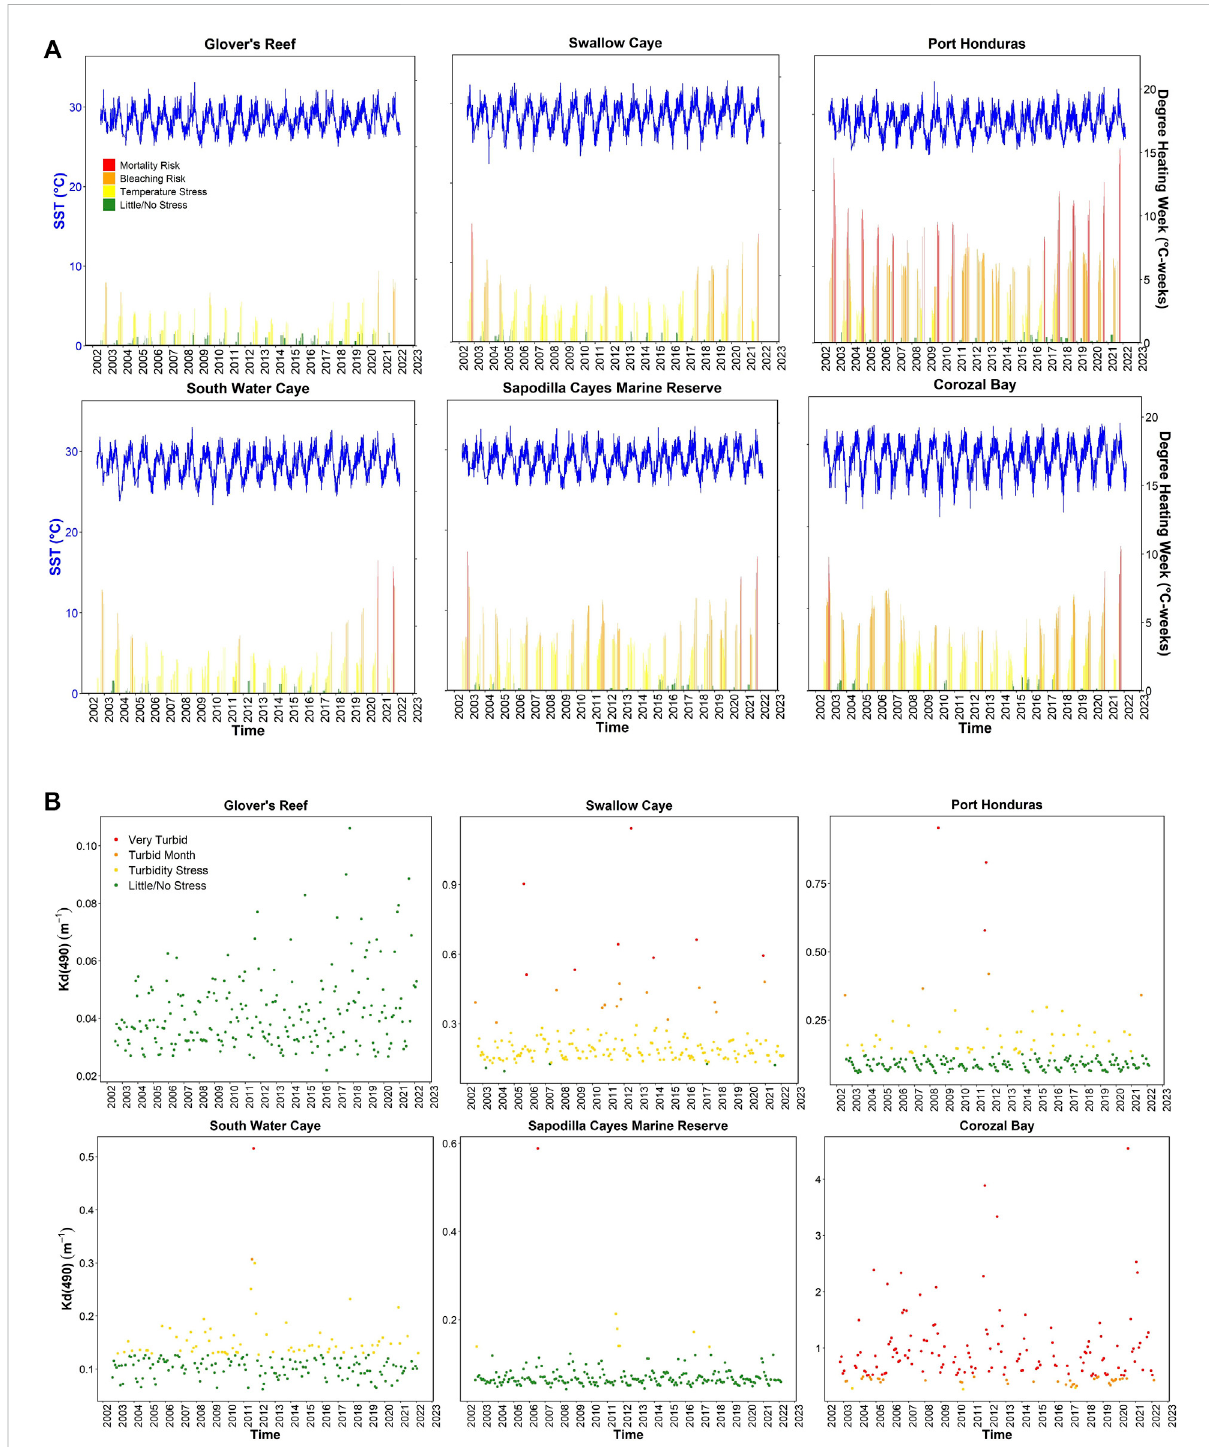
FIGURE 3 Seasurfacetemperature,degreeheatingweeks,andKd(490)forselectMPAsfrom2002to2022. (A) DepictsSSTandDHWweeksforsixmarine protected areas (Glover ’ s Reef, Swallow Caye, Port Honduras, South Water Caye, Sapodilla Cayes Marine Reserve, and Corozal Bay). (B) Shows Kd (490) values for the same MPAs from 2002 to